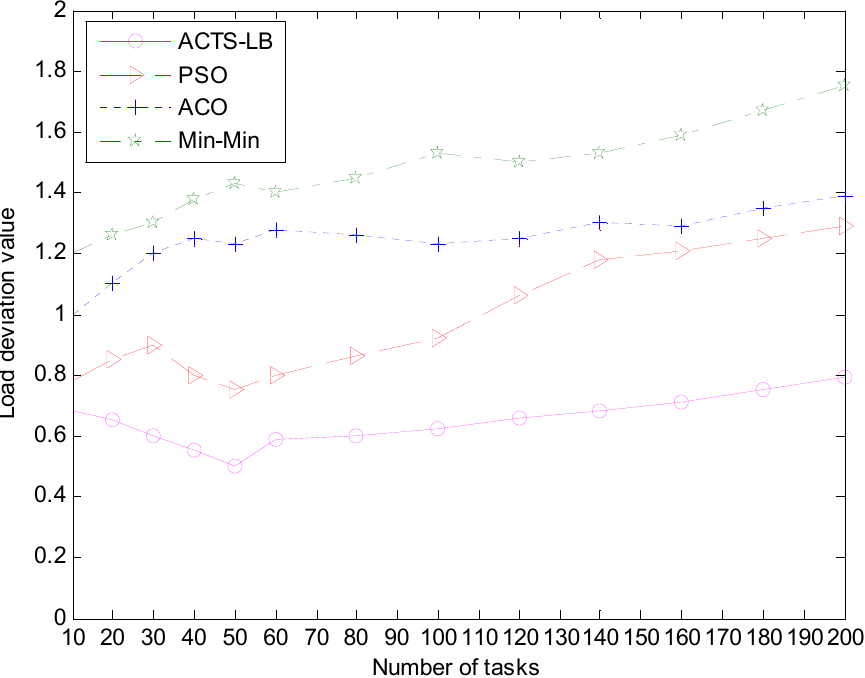
Figure 9. The comparison of system load deviation values under different scheduling tasks.